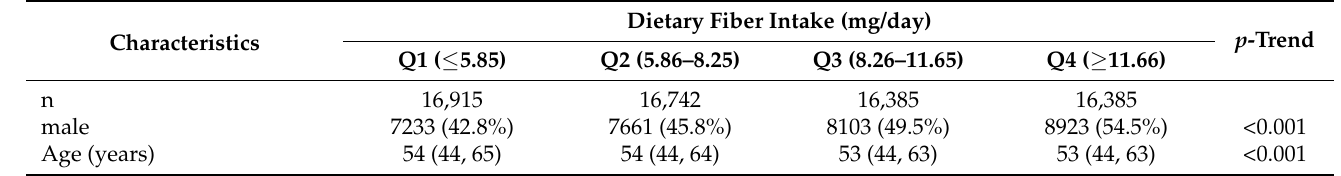
Table 2. Sample characteristics of participants according to quartile of dietary fiber intake ( n = 66,427).